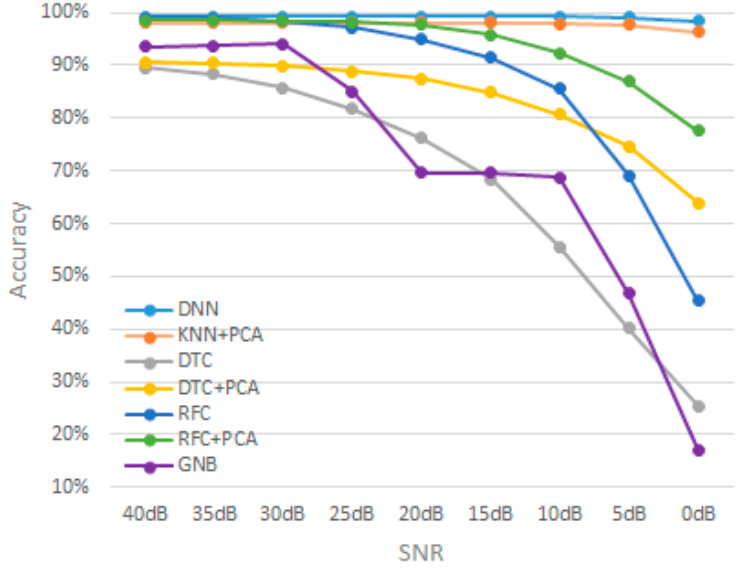
Figure 4. Accuracy trend for machine learning models with the increase of thermal noise power.